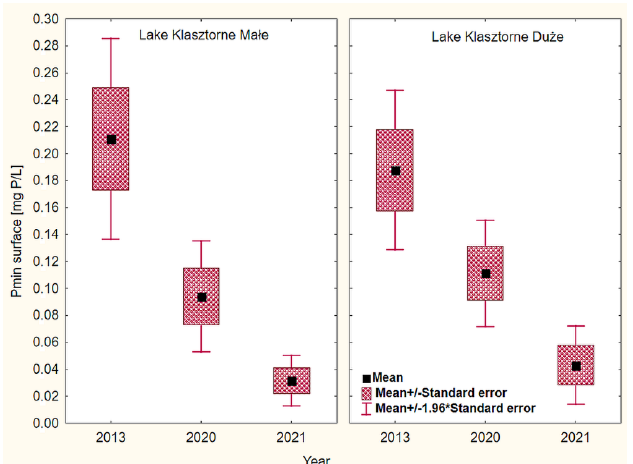
Figure 5. Average annual values of mineral phosphorus (P min .) in the surface water of Klasztorne lakes in selected research years. The bottom waters were richer in mineral phosphorus. In LKM, phosphate concen- trations varied from 3.500 mg P/L (in 2021 — year of restoration) to 16.200 mg P/L (during protection measures in 2020) (Figure 6a,b). In the eutrophic LKD, the range of mineral phosphorus concentrations in the analyzed period was not as wide as in the meromictic reservoir and ranged between 0.011 mg P/L (2021 — restoration) and 1.004 mg P/L (2013 — before the protection and restoration of the lake) (Figure 6a,b). ( a )